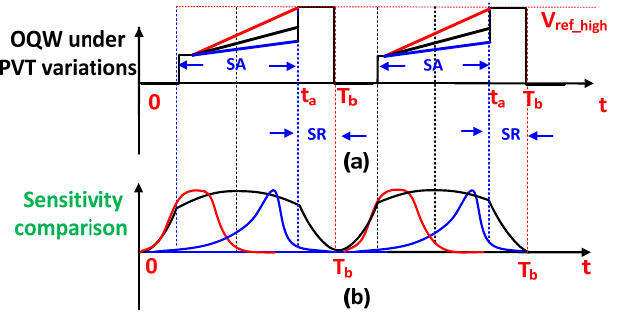
Figure 6. Optimal quenching waveform under PVT variations: ( a ) OQW slope variations and ( b ) sensitivity variations under slope variations.